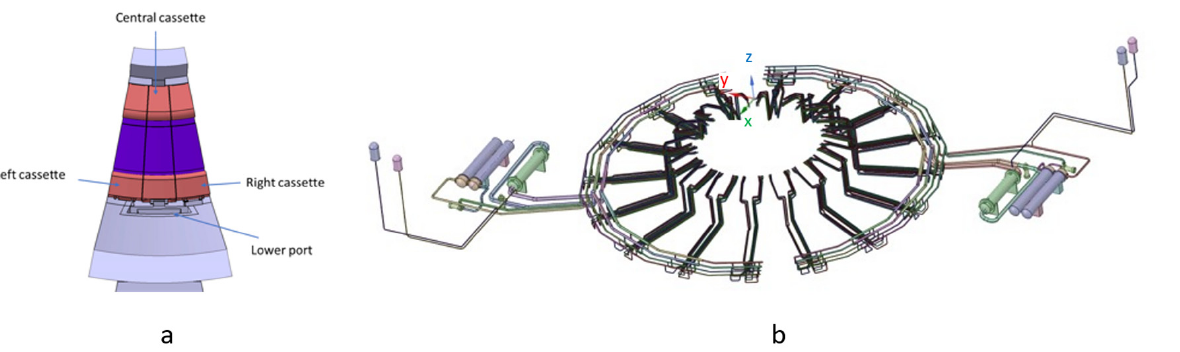
Figure 4. Divertor cassette and target assembly for a segment ( a ), heat-transfer system for Divertor cassette and target for DEMO’s 16 sectors ( b